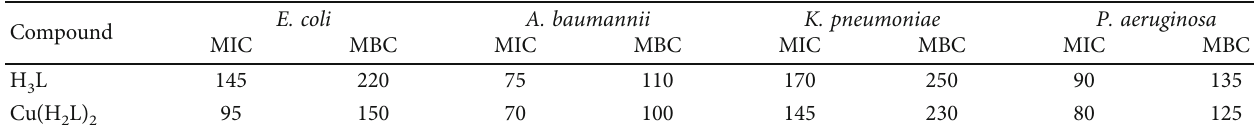
Table 4: Antimicrobial activity (MIC/MBC) ( μ g/ μ L) of compounds. E.